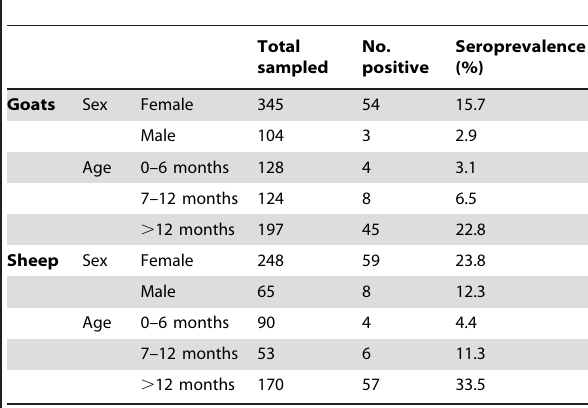
Table 3. RVF seroprevalence by sex and age group in